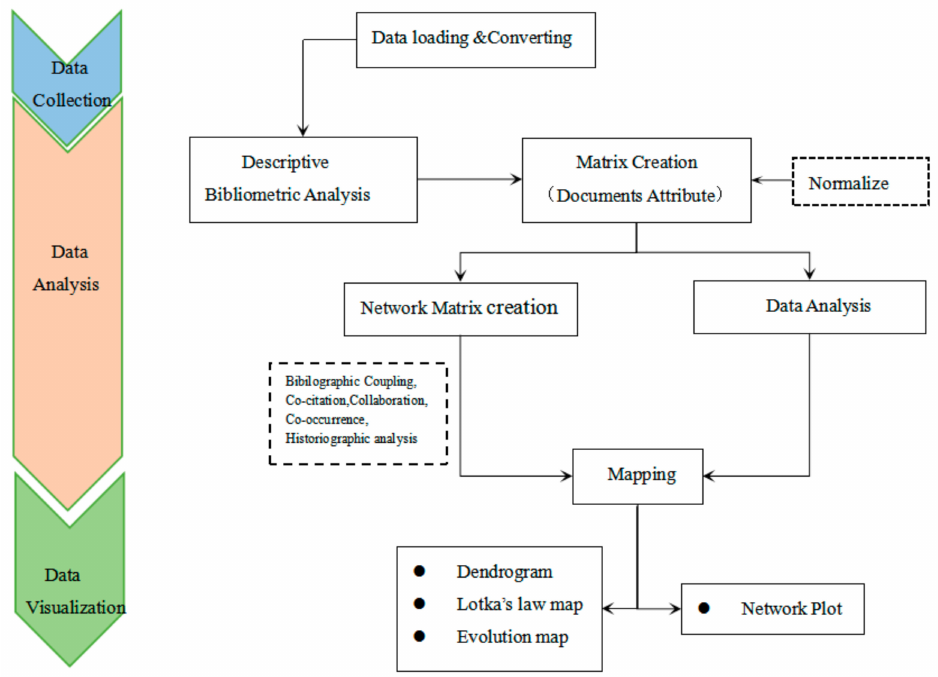
Figure 1. Bibliometrics analysis workflow of this